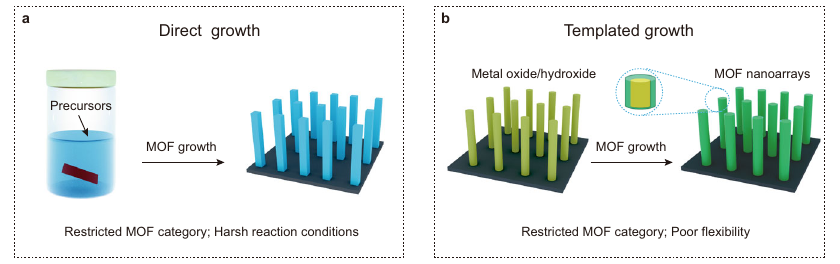
Fig. 1 | Traditional routes to MOF nanoarrays. a Direct growth of MOF nanoarrays under solvothermal conditions. b Directed growth of MOF nanoarrays on hard templates.